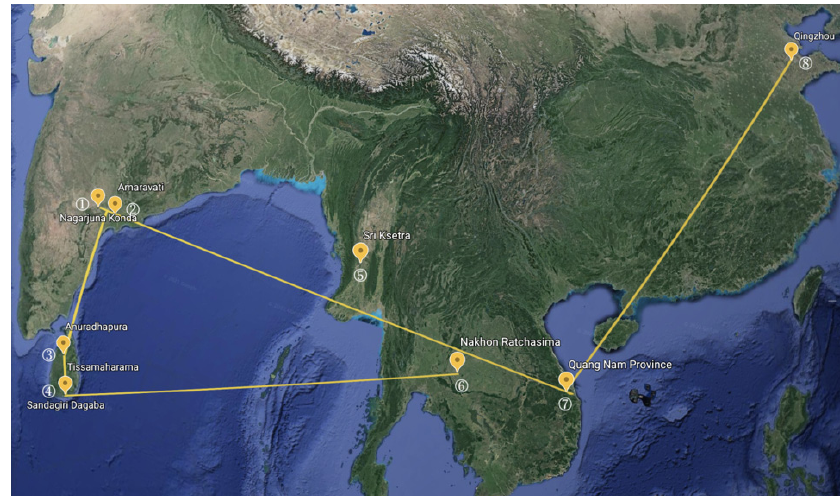
Figure 5. Schematic diagram of the transmission route of standing Buddha statues with densely pleated robe covering only the left shoulder (type B). ① Nagarjunakonda, Krishna River Valley, India; ② Amaravati, Krishna River Valley, India; ③ Anuradhapura, Sri Lanka; ④ Sandagiri Dagaba, Tissamaharama, Sri Lanka; ⑤ Sri Ksetre, Myanmar; ⑥ Nakhon Ratchasima, Thailand; ⑦ Dong Duong, Quang Nam Province, Vietnam; ⑧ Longxing Temple Site, Qingzhou, Shandong Peninsula, China.